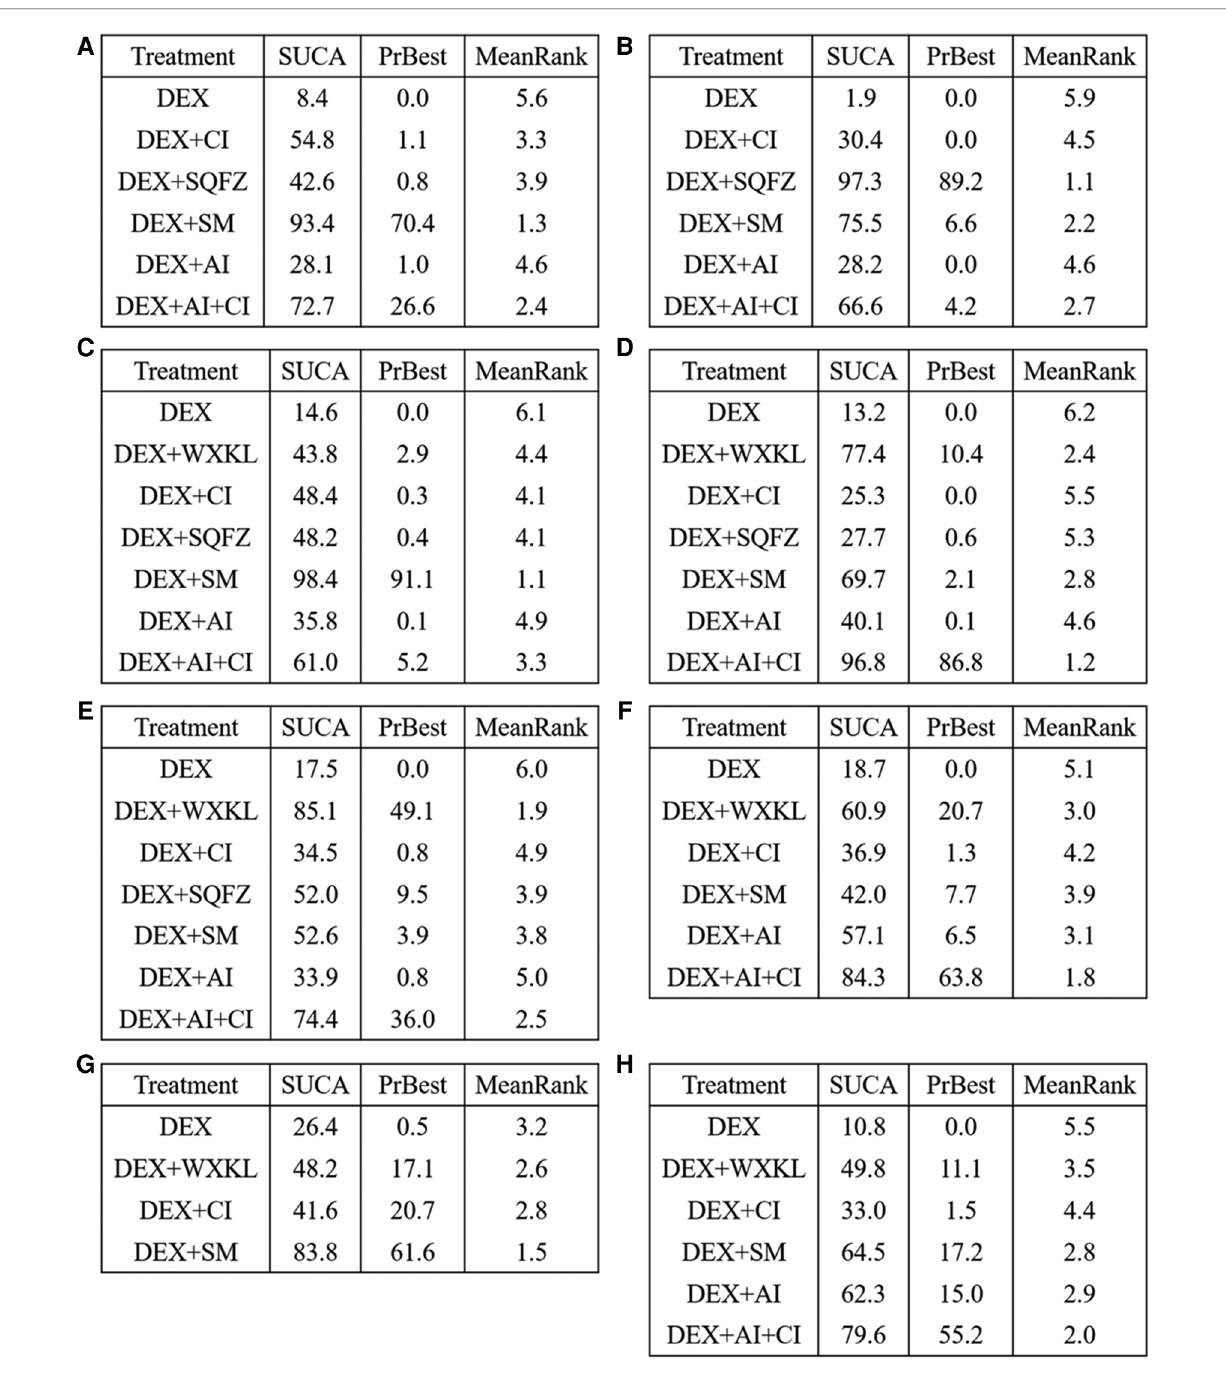
FIGURE 6 SUCRA rank of each intervention. ( A ) cTnI. ( B ) CK-MB. ( C ) LVEF. ( D ) Rate of abnormal of ECG. ( E ) ST-T change abnormal. ( F ) Sinus tachycardia. ( G ) Atrioventricular block. ( H ) Premature beat (DEX, Dexrazoxane; DEX+WXKL, Dexrazoxane combined with Wenxinkeli; DEX+CI, Dexrazoxane combined with Cinobufotalin injection; DEX+SQFZ, Dexrazoxane combined with Shenqifuz)heng injection; DEX+SM, Dexrazoxane combined with Shenmai injection; DEX+AI, Dexrazoxane combined with Astragalus injection; DEX+AI+CI, Dexrazoxane combined with Astragalus with Cinobufotalin